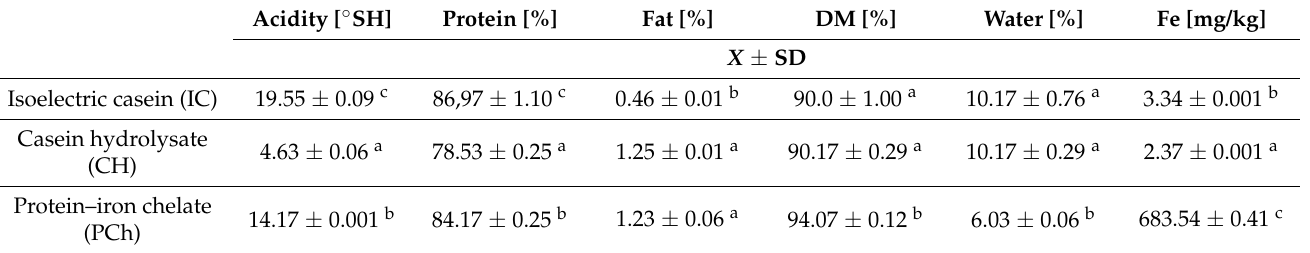
Table 1. Acidity and composition of isoelectric casein (IC), isoelectric casein hydrolysate (CH), and protein–iron chelate (PCh) obtained by hydrolysis with serine protease from Yarrowia lipolytica yeast. Acidity [ ◦ SH] Protein [%] Fat